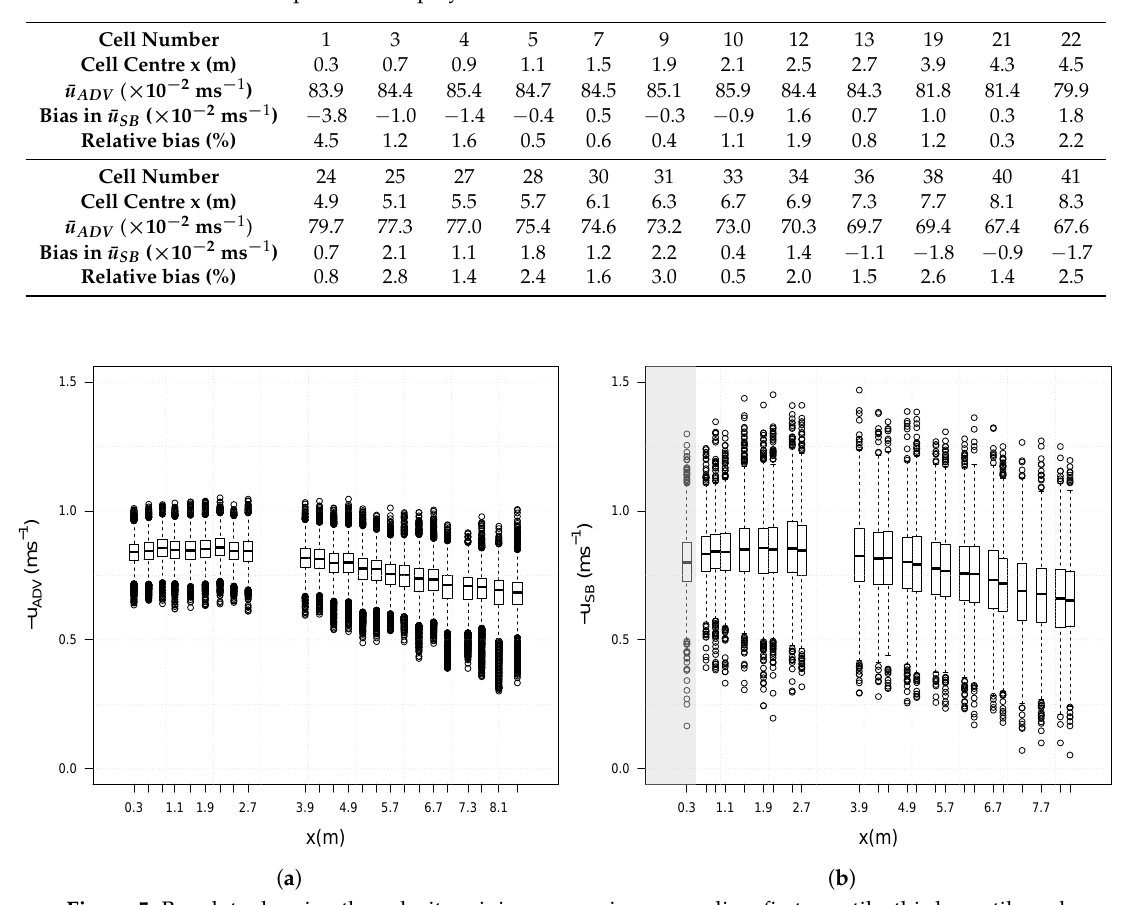
Figure 5. Boxplots showing the velocity minimum, maximum, median, first quartile, third quartile and outliers for the ( a ) ADV from the SuperGen Marine tidal array project [8,29] and ( b )